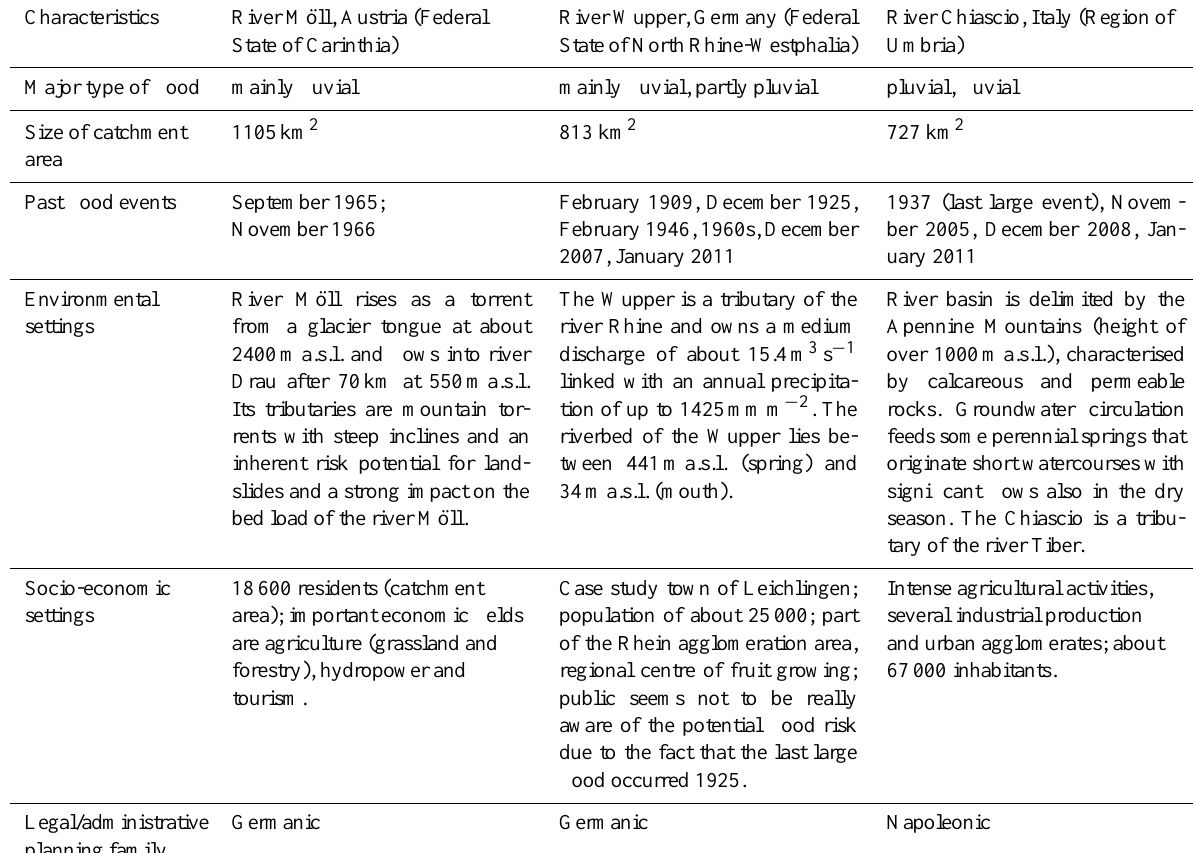
Table 1. Case study areas (source: AKL, AB Tevere,